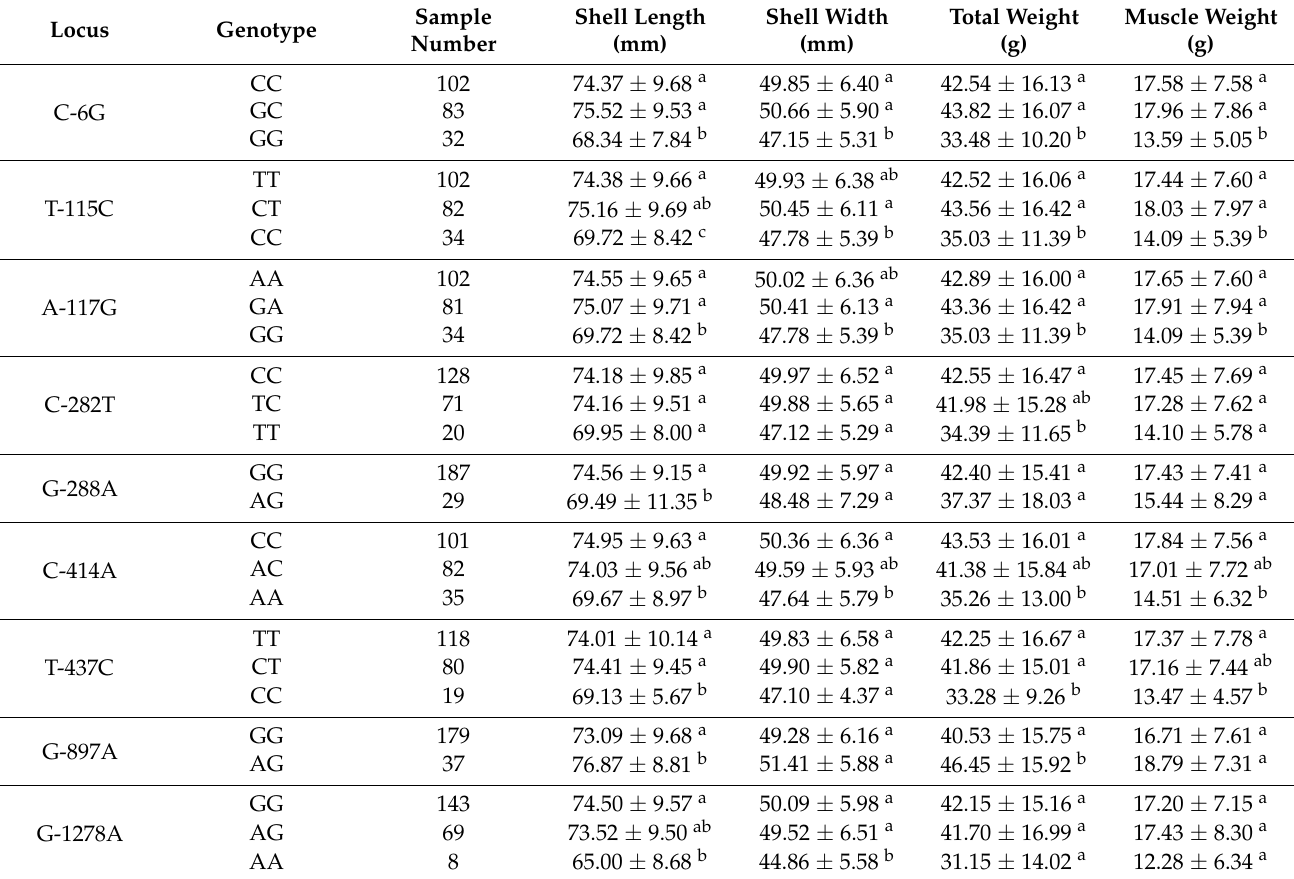
Table 2. Correlation of SNPs in hdh-myostatin with growth traits in the Haliotis discus hannai (mean ± SD).